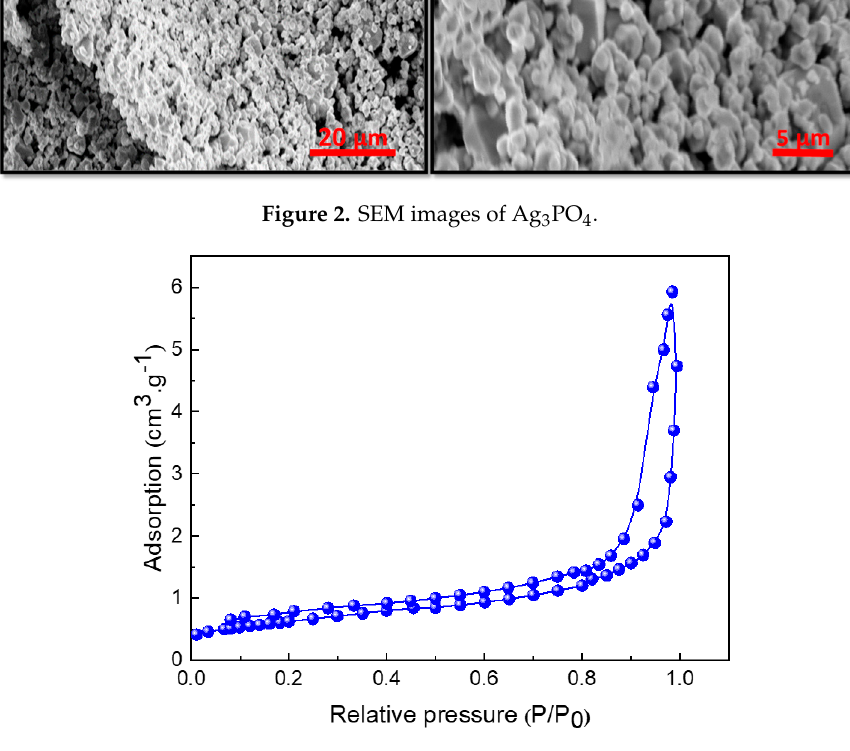
Figure 3. BET of Ag 3 PO 4 at 77 K. Table 1. Textural characteristics of Ag 3 PO 4 .